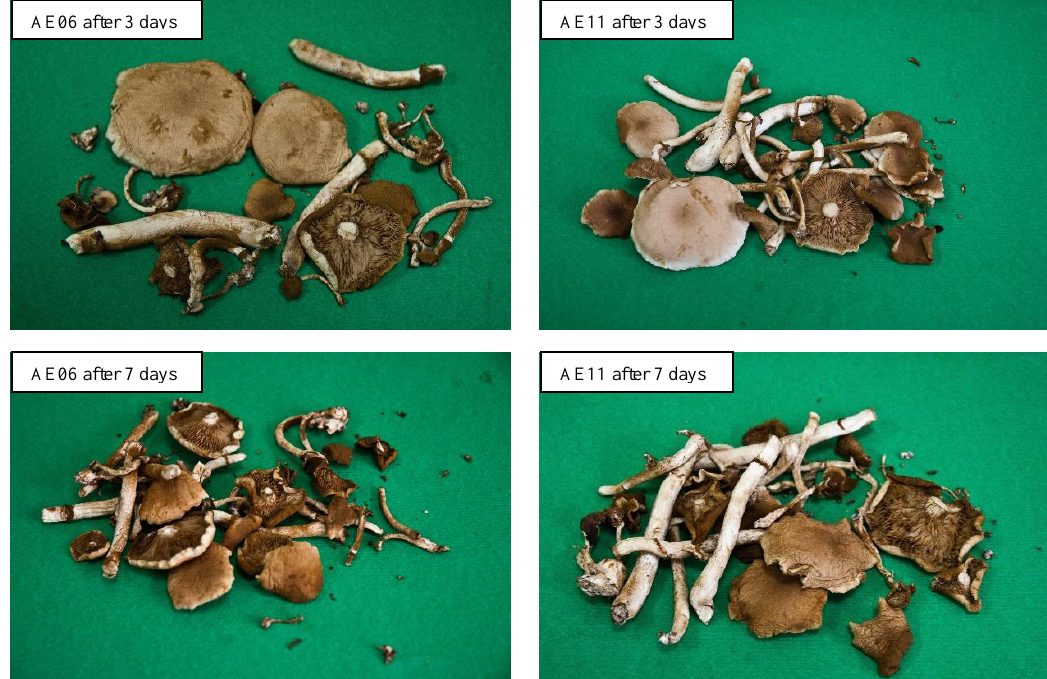
Figure 4. Fruiting bodies of strains AE06 and AE11 obtained from substrate with addition of 2 g of CaCO 3 per 100 g DM substrate after 3 and 7 days of storage